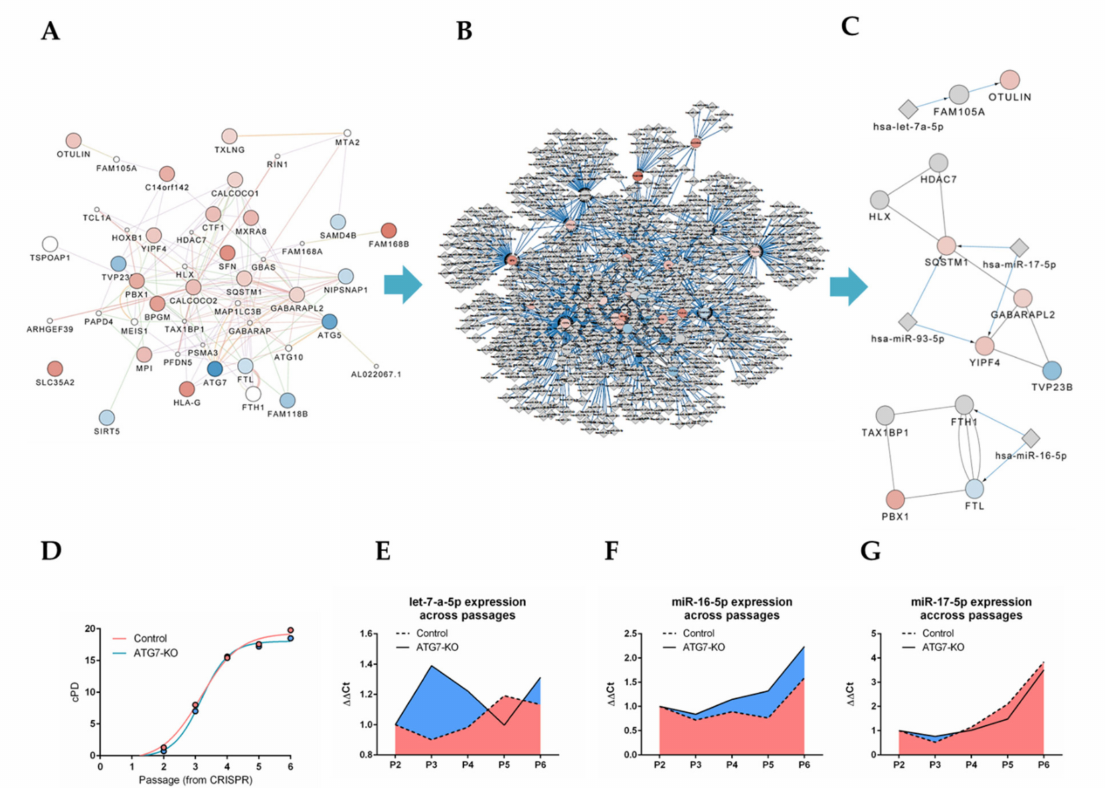
Figure 4. Comprehensive bioinformatics proteome profiling analysis. ( A ) Significantly deregulated protein interaction network. Red spheres indicate upregulated proteins, blue indicate downregulated proteins. White spheres are inserted predicted interaction partners. ( B ) miR-regulated network analysis of all possible miR regulators of network proteins. ( C ) The functional cluster analysis identified three functional cluster modules between miR-16-5p, miR-17-5p, let-7a-5p, miR-93-5p and their targets related to the network proteins. ( D ) Cumulative population doubling curve (cPD) of control and ATG7-KO-MRC-5 fibroblasts. ( E – G ) Relative expression levels ( ∆∆ Ct) of let-7a-5p, miR-16-5p and miR-17-5p normalized to Small nucleolar RNA SNORD48 (RNU-48). P signifies passage